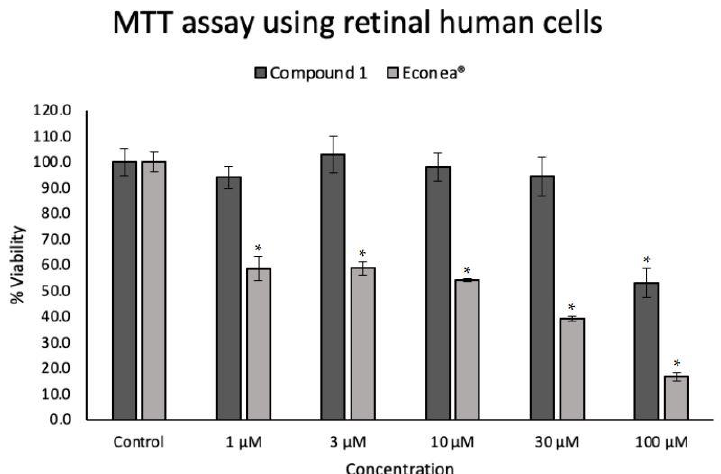
Figure 2. Cytotoxicity evaluation of compound 1 , a promising NIAF, and the emerging biocide Econea ® . Cell viability was determined by MTT assay in human immortalized retinal pigment epithelial cell line (hTERT-RPE-1) after 24 h of several treatment concentrations. Values are expressed as mean ( n = 3) ± SD. * p < 0.05 compared with the control group.